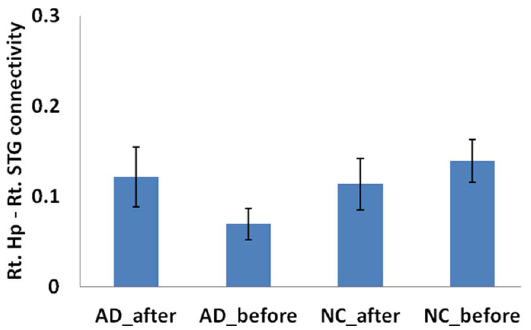
Figure 6. Comparison of connectivity of right hippocampus and right STG between pre and post acupuncture among AD patients and controls. The acupuncture induced increased functional connectivity for the AD patients (t=1.458, p=0.08). There was no significant difference for healthy controls (t=0.675, p=0.254).